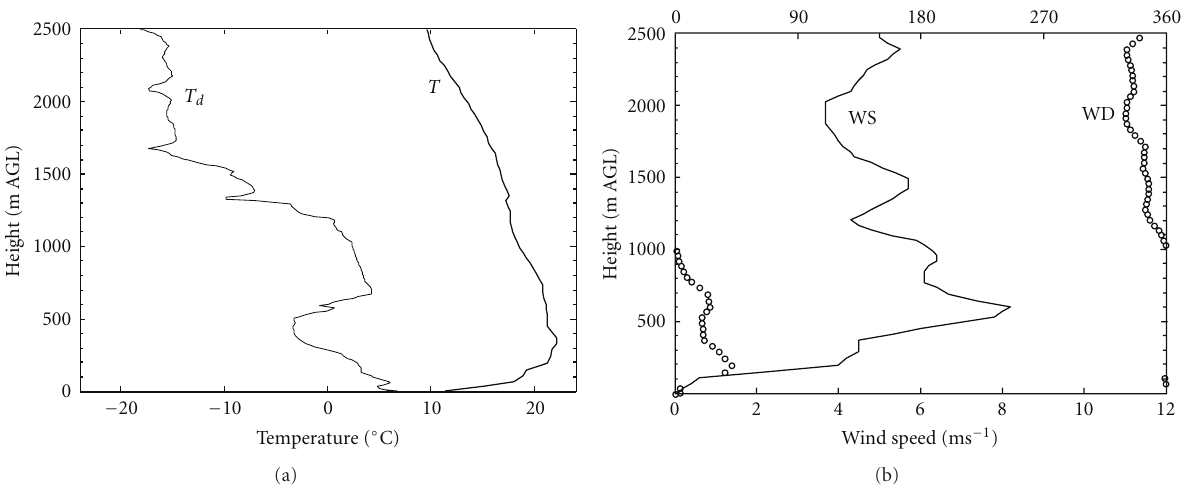
Figure 4: Vertical profiles of (a) air temperature T and dew point temperature T d and (b) wind speed (WS) and wind direction (WD) at Stockman’s Field ( ∼ 1.5km north northwest of the burn unit) for the day of the burn, 7 October 2008 at 0800 PDT.